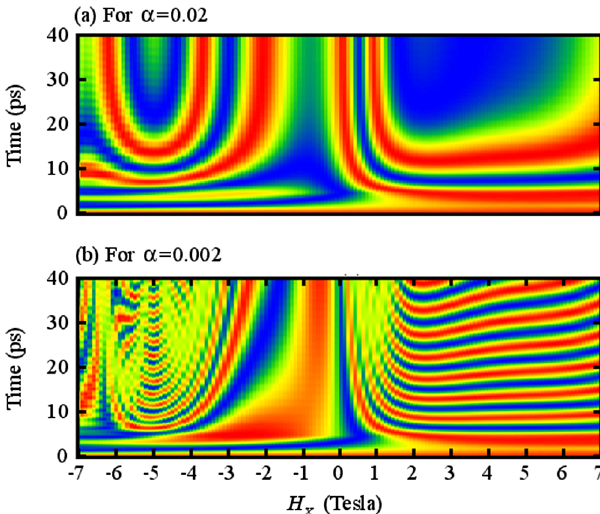
FIG. 3. The switching phase diagram of an Fe/Cr/Fe trilayer at T ¼ 0 K . The duration of the magnetic pulse is 5 ps, and the x component of the magnetic field is shown on the x axis, whereas the z component is 5 T. A uniaxial anisotropy of 0.06 mRy is considered in the calculations, providing an easy-plane magne- tization. The x component of the magnetization of the top Fe slab of Fig. 1 is shown in a color scheme. The blue (red) areas indicate the regions where switching has occurred (not oc- curred). (Also, see the text for a description.) In (a) we show simulations for a damping parameter of 0.02 and in (b) the damping parameter is 0.002. H z ¼ 5 T and j K j ¼ 0 : 06 mRy